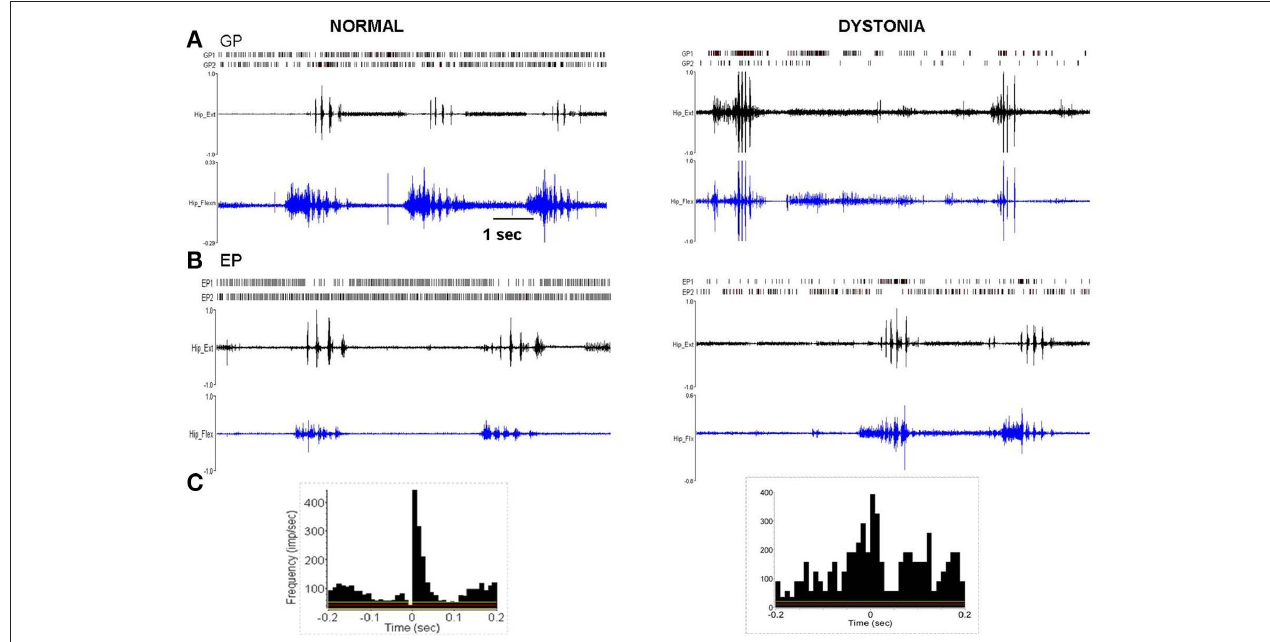
second neuron (EP1) shows coincident increased movement related discharge activity (a rare co-occurrence in our sample). (C) Peri-event histograms corresponding to the examples in Figure 4A confer significant movement related related increases in discharge activity. The histograms illustrate collective neuronal discharge activity ( y -axis) 200 ms before and after the onset of voluntary movement over multiple movement epics (minimum 15). The voluntary movements were either self-initiated or followed a brief flexor withdrawal response in response to light touch of the animal’s tail by the examiner. Red lines indicate the mean firing rate and yellow lines indicate the 95% confidence intervals. Bin size is 10 ms.